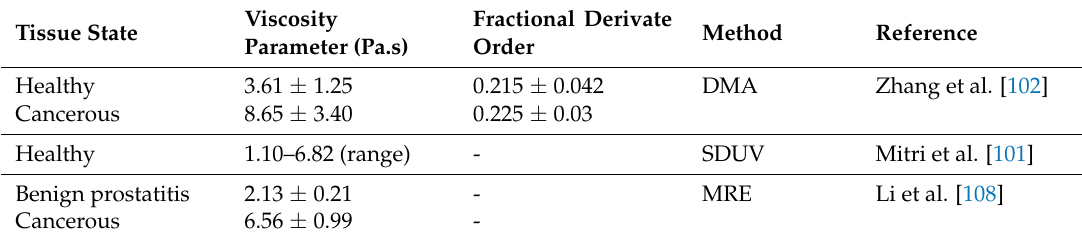
Table 4. Viscosity parameters derived from different methods, including a Kelvin–Voigt fractional derivative (KVFD) fitting using dynamic mechanical analysis (DMA), KV fitting on shear wave dispersion ultrasonic vibrometry (SDUV) and magnetic resonance elastography (MRE) results of prostatic tissue. Values are reported as means and standard